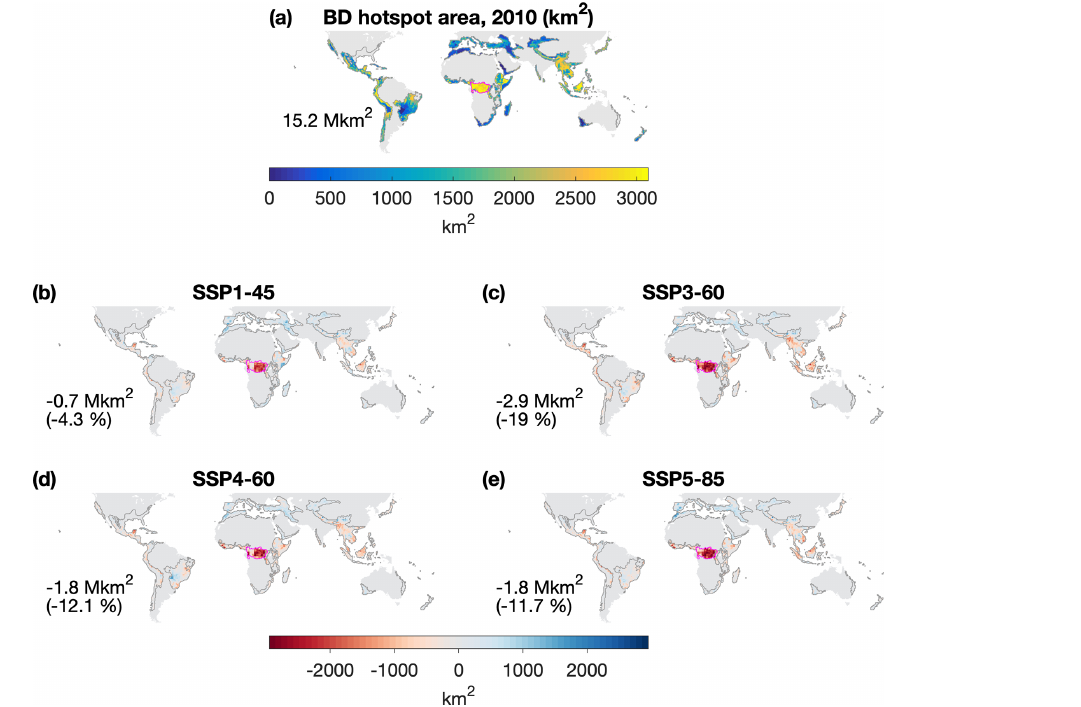
Figure 7. (a) Area (from LUH2) of non-agricultural land in “CI+CSLF” hotspots in 2010; (b–e) change in non-agricultural land area there by 2100 for each scenario. Black outlines indicate CI hotspots; magenta outline indicates CSLF